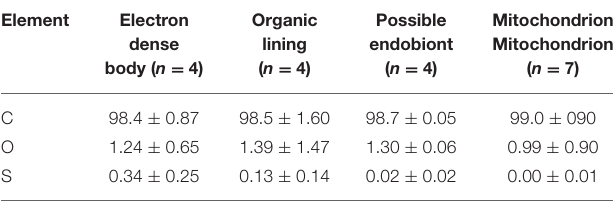
TABLE 3 | Relative abundances (atomic %) of C, O, and S in Ammonia sp. incubated with anoxia. Element Electron Organic Possible Mitochondrion